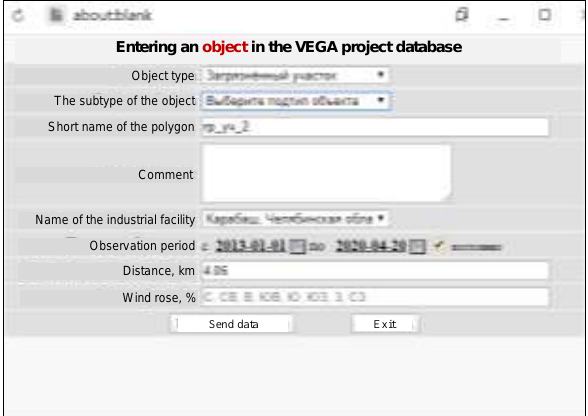
Figure 4. Registration of TWDS control plots